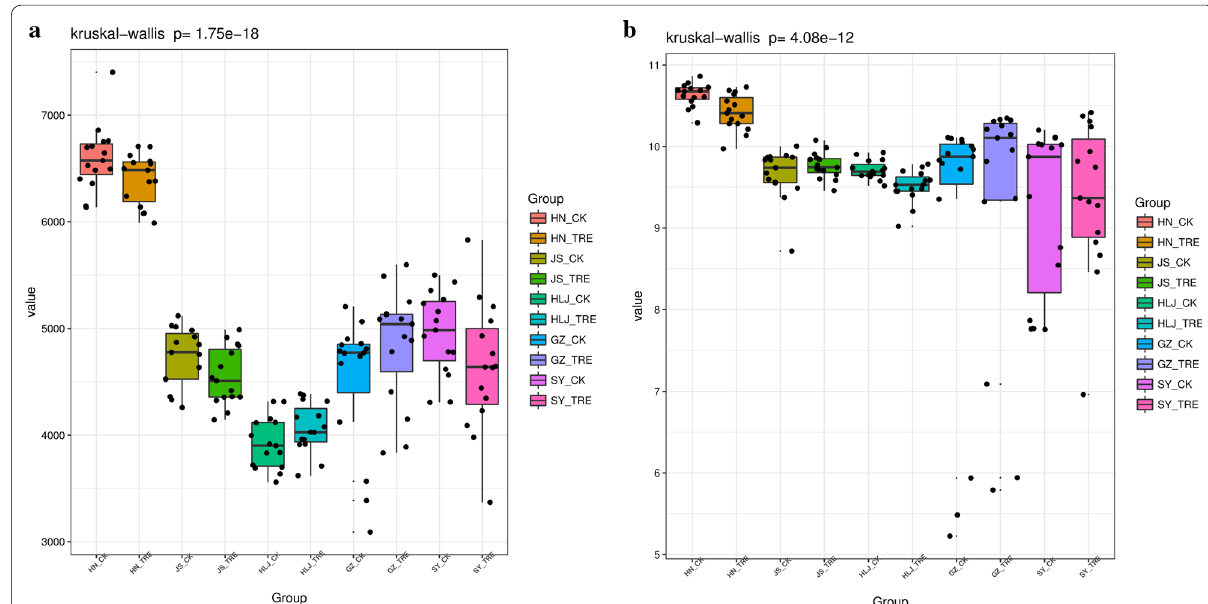
Fig. 2 Alpha-diversity indices, a Chao1 and b Shannon indices, of the bacterial community structure in BIO-treated and untreated soil samples at five rice paddy sites. The HN_CK, HN_TRE, JS_CK, JS_TRE, HLJ_CK, HLJ_TRE, GZ_CK, GZ_TRE, SY_CK and SY_TRE represent BIO treatment and untreated control at the five rice paddy sites in China